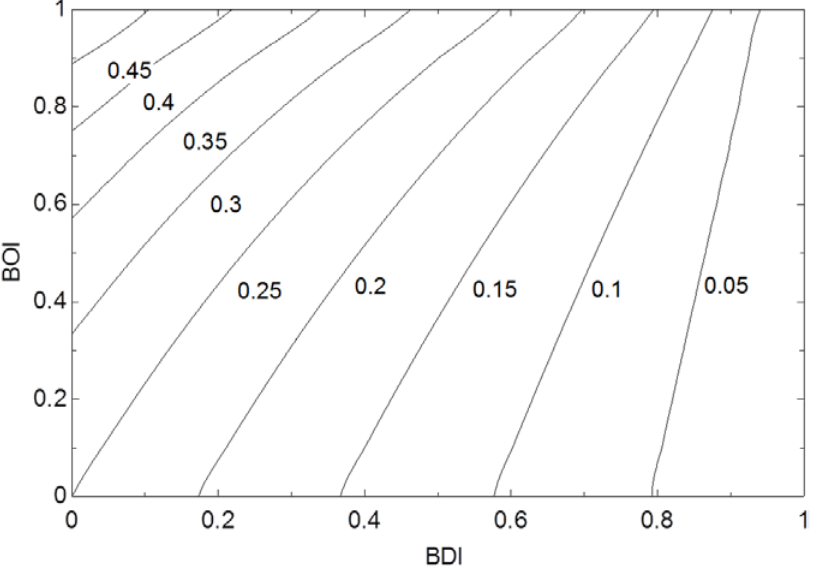
Figure 9. Building energy savings due to upgrading